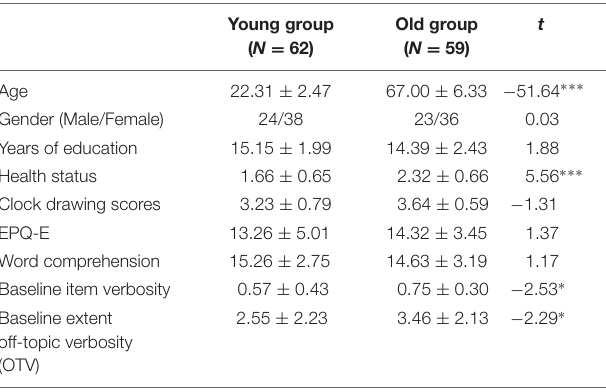
TABLE 1 | Demographic information and baseline performances of the participants in participants recruitment